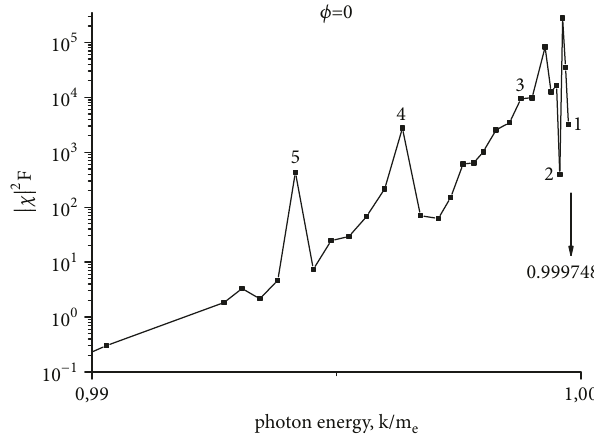
Figure 8: The integrand function in (91) for the angle 𝜙 = 0 in the region of the photon energies 0.99 ≤ 𝑘 ≤ 0.999748